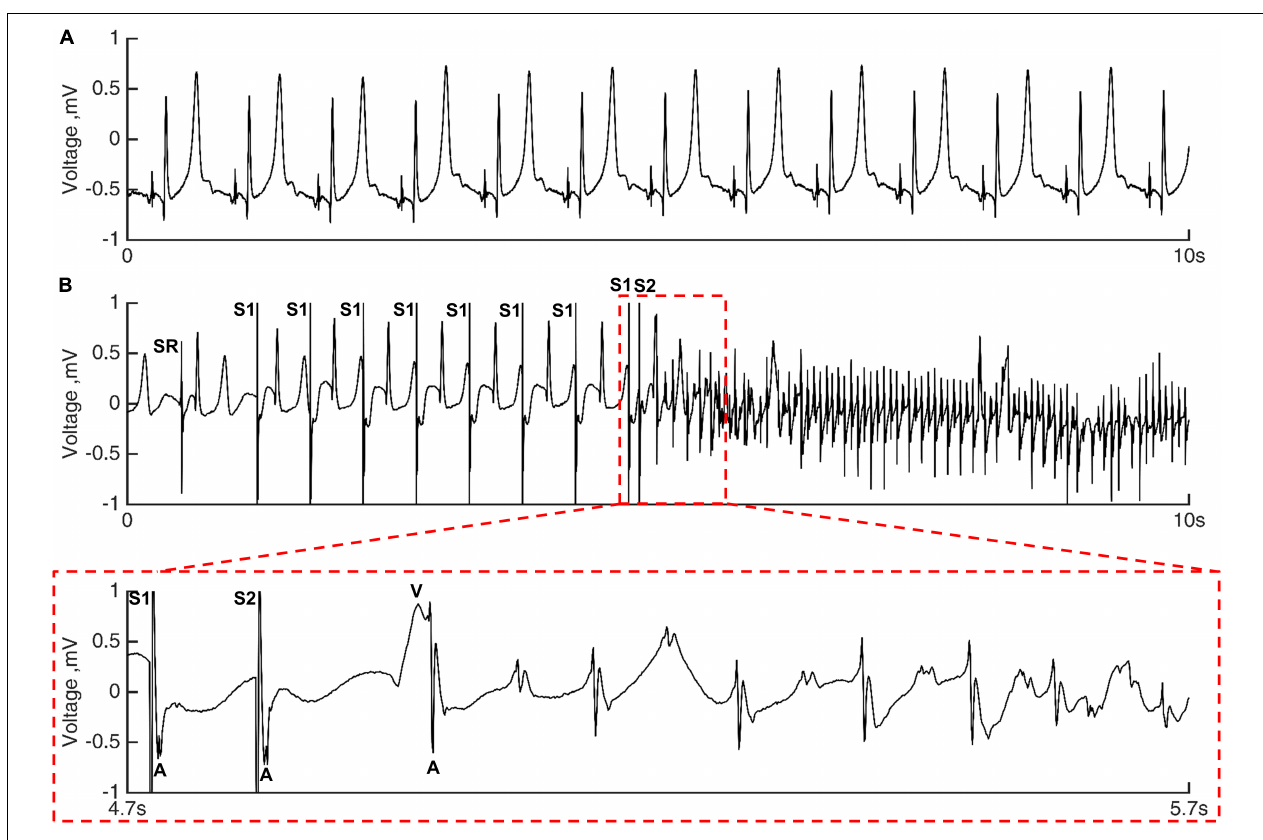
FIGURE 2 | Unipolar electrograms tracings. (A) RPV electrograms during sinus rhythm in a heart with PV scar in high LA pressure. The hearts were in sinus rhythm before each induction attempt. (B) Tracing of atrial fibrillation (AF) induction in the same PV scar heart by premature stimulation in the LPV in high LA pressure. Local atrial and far-field ventricular activation are indicated with A and V, respectively. S1 denotes eight stimuli with a cycle length of 500 ms, and S2 marks the premature stimulus (S1–S2 coupling interval = 100 ms). The sinus rhythm (SR) occurring during the 1,000 ms pause before the first S1 stimulus is noted.